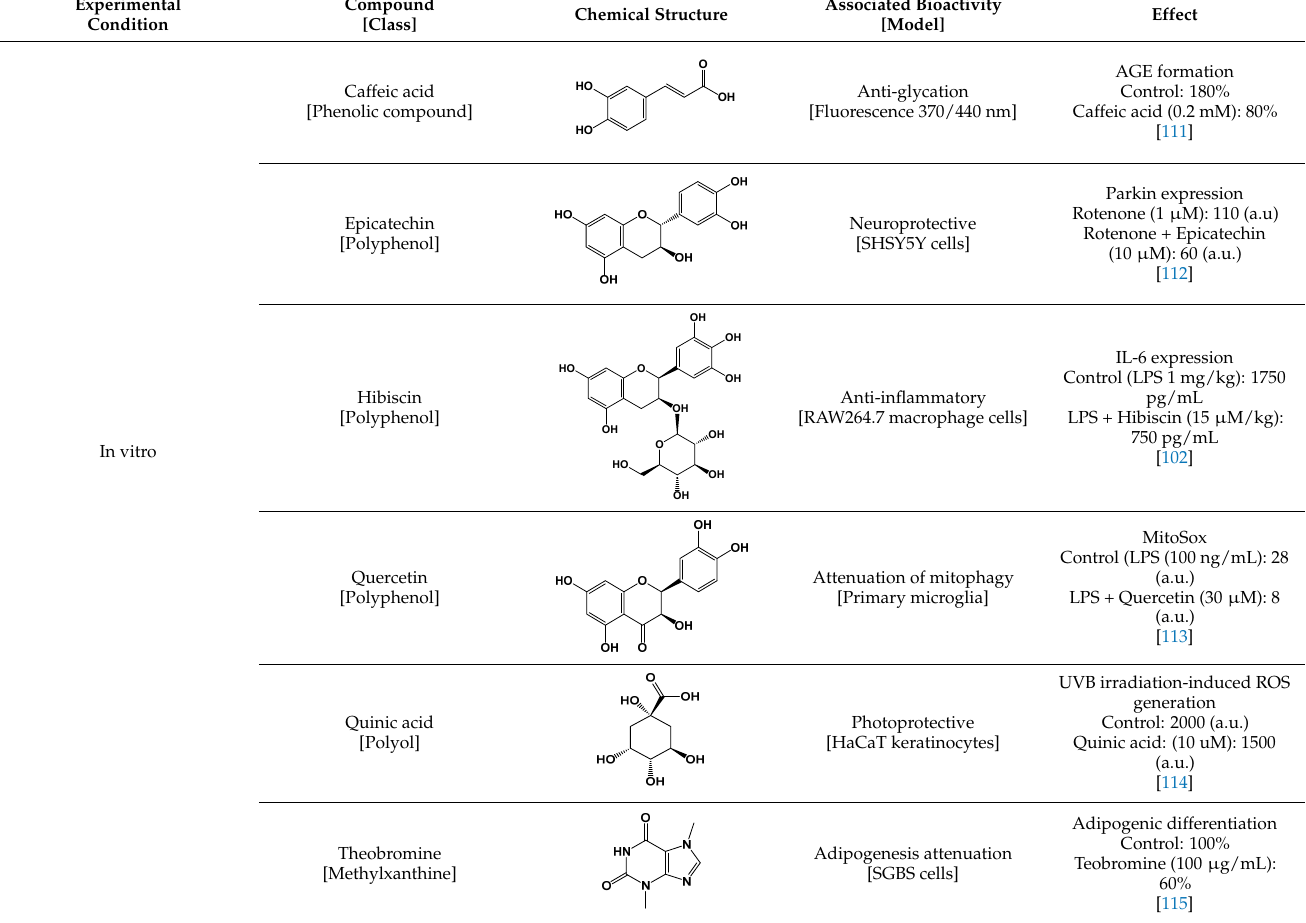
Table 1. Reported bioactive natural products in rooibos, hibiscus, and/or yerba mate extracts.